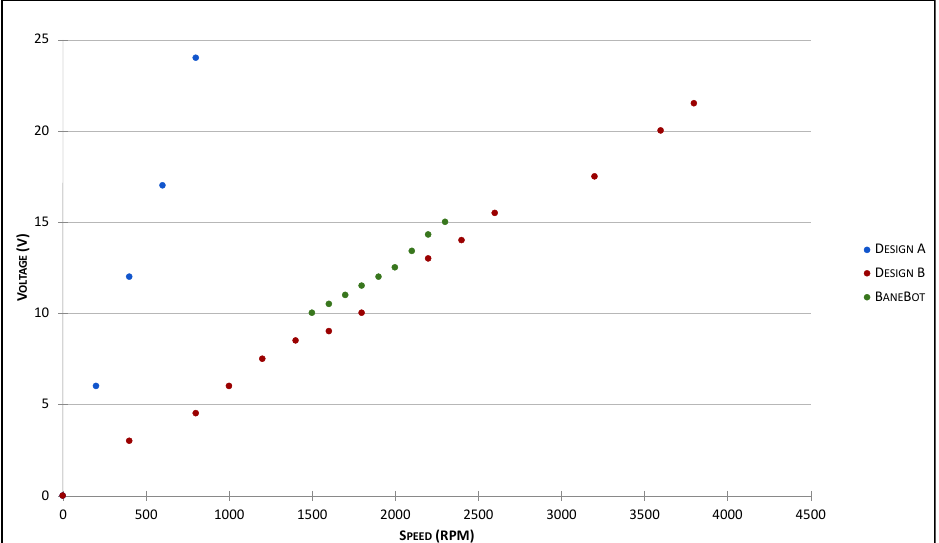
Figure 15. A comparison of the flywheel RPM vs. generated voltage characteristics of the three designs being compared.